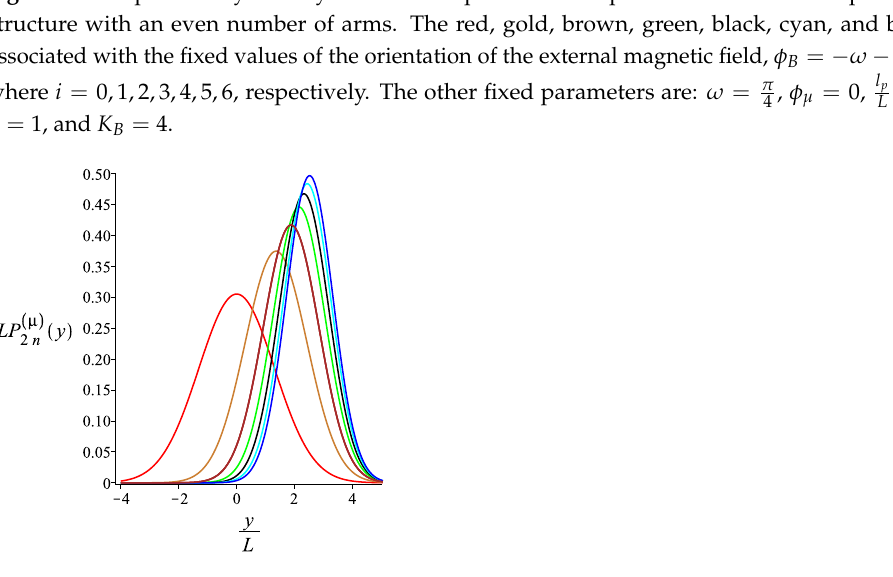
Figure 10. The probability density of the y component of the position of the free endpoint of the grafted structure with an even number of arms. The red, gold, brown, green, black, cyan, and blue are associated with the fixed values of the magnetic interaction parameter, K B = 0,3,6,9,12,15,18, respectively. The other fixed parameters are: ω = π